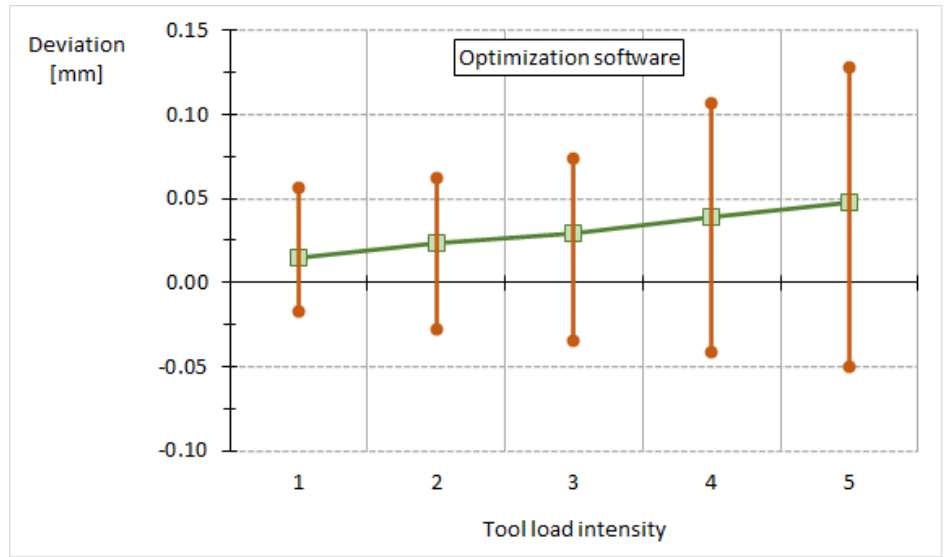
Figure 8. Deviations on the sidewalls of the pockets made with optimization software.